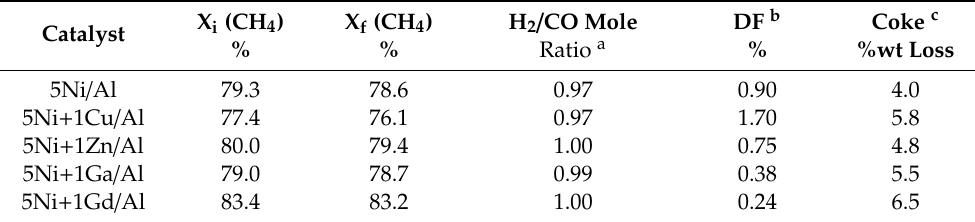
Table 2. Conversion of CH 4 , H 2 / CO ratio and deactivation factor (DF) for non-promoted and promoted catalysts.